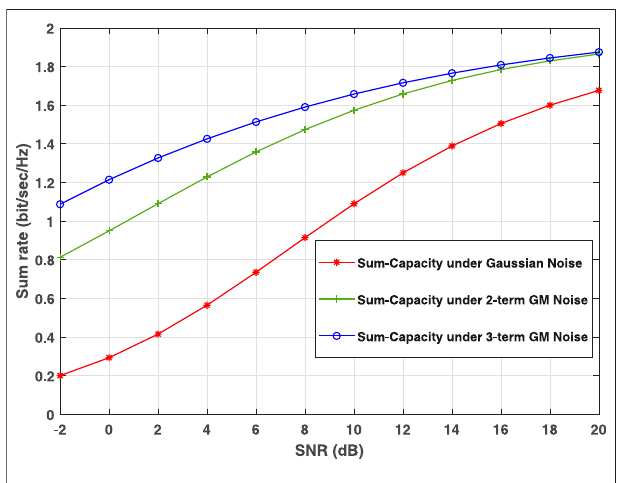
FIGURE 6 | Sum-rates achieved by different pairs of input signals over the 3-term GM MAC. The two users are assumed to have unequal transmit power P 1 (cid:2) P and P 2 (cid:2) 3P.